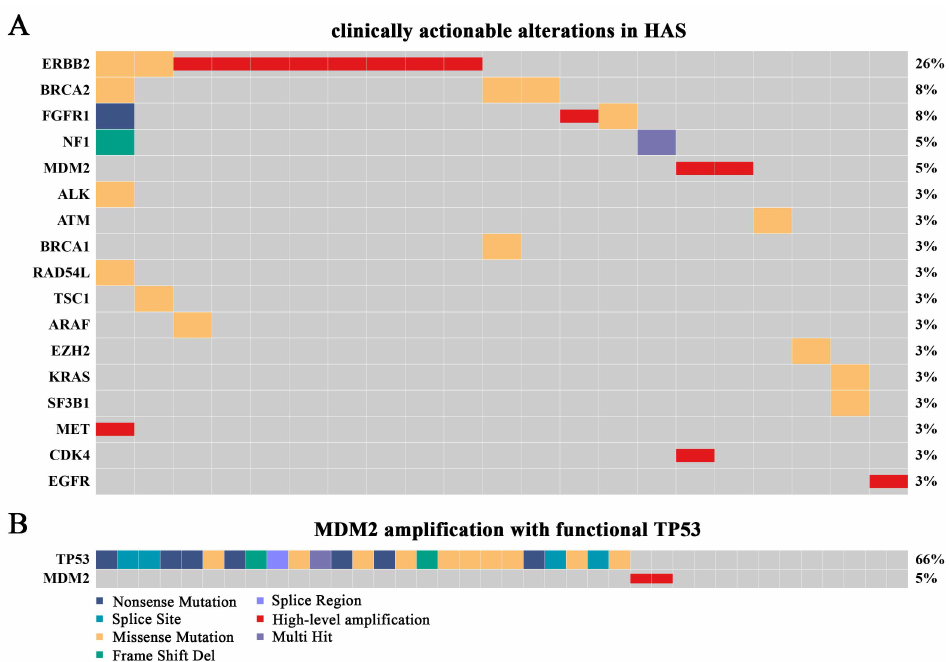
Figure 5. Overview of clinically actionable alterations in HAS. ( A ) The landscape of potentially targetable alterations based on the results of SNVs, INDELS, high-level amplifications, and deep deletions. Different variant types are highlighted in different colors. ( B ) Patients with high-level amplification of MDM2 and functional TP53